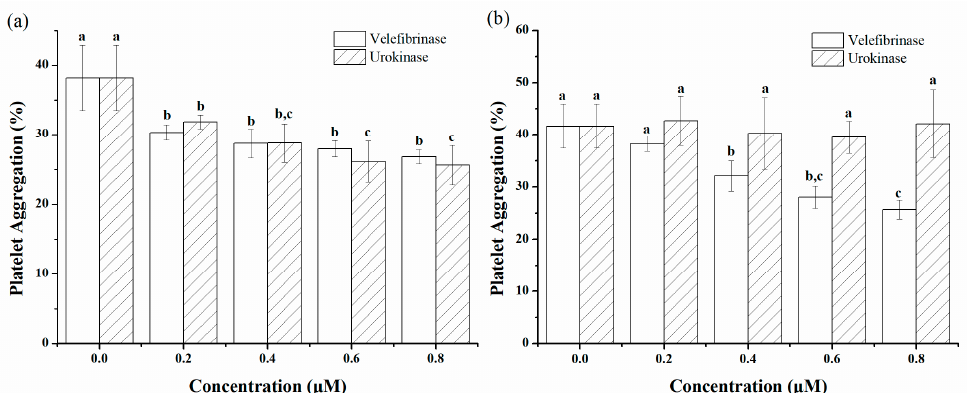
Figure 5. Determination of the platelet aggregation rate induced by adenosine diphosphate (ADP) in vitro. The effect of Velefibrinase and urokinase (0–0.8 μ M) on platelet aggregation in ( a ) platelet-rich plasma (PRP) or ( b ) wash platelet (WP). Data represent mean ± standard deviations (SDs) of triplicate experiments. Different letters indicate significant differences ( p < 0.05) in each group.